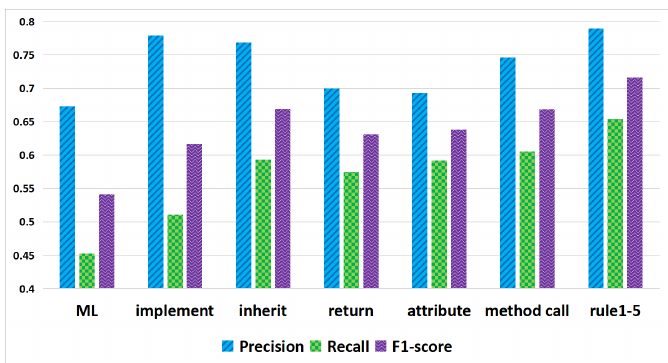
Figure 14. Results of using various structural information features of source code to perform traceability link recovery.